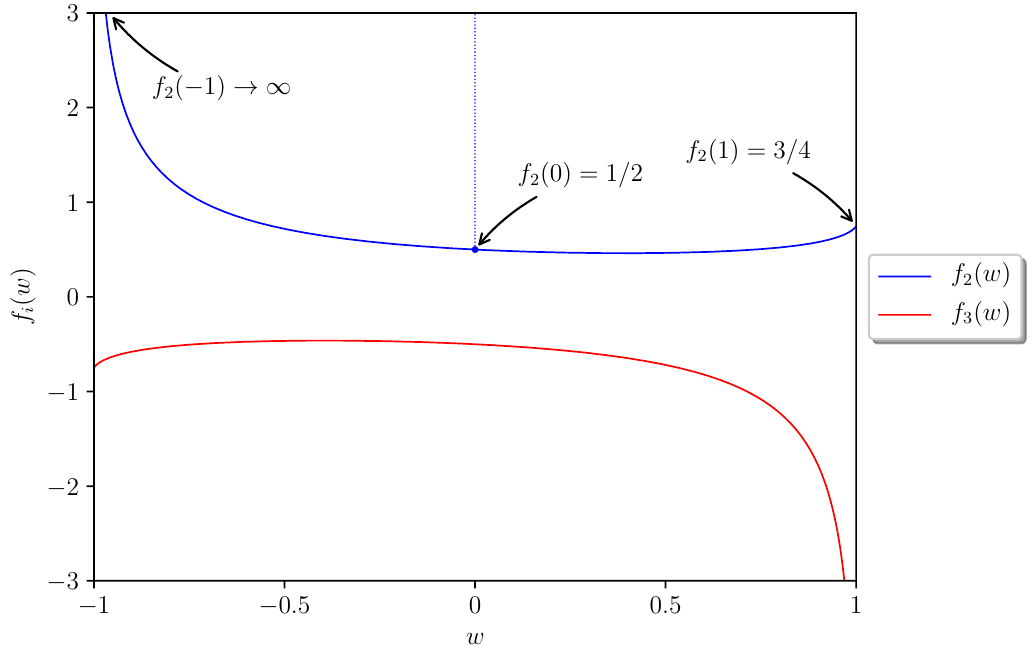
Figure 1 . Asymmetry functions f 2 ( w ) and f 3 ( w ) , equation (2.17), with values for the limiting cases w ∈ {− 1 , 0 , 1 } of f 2 ( w ) , corresponding to q 2